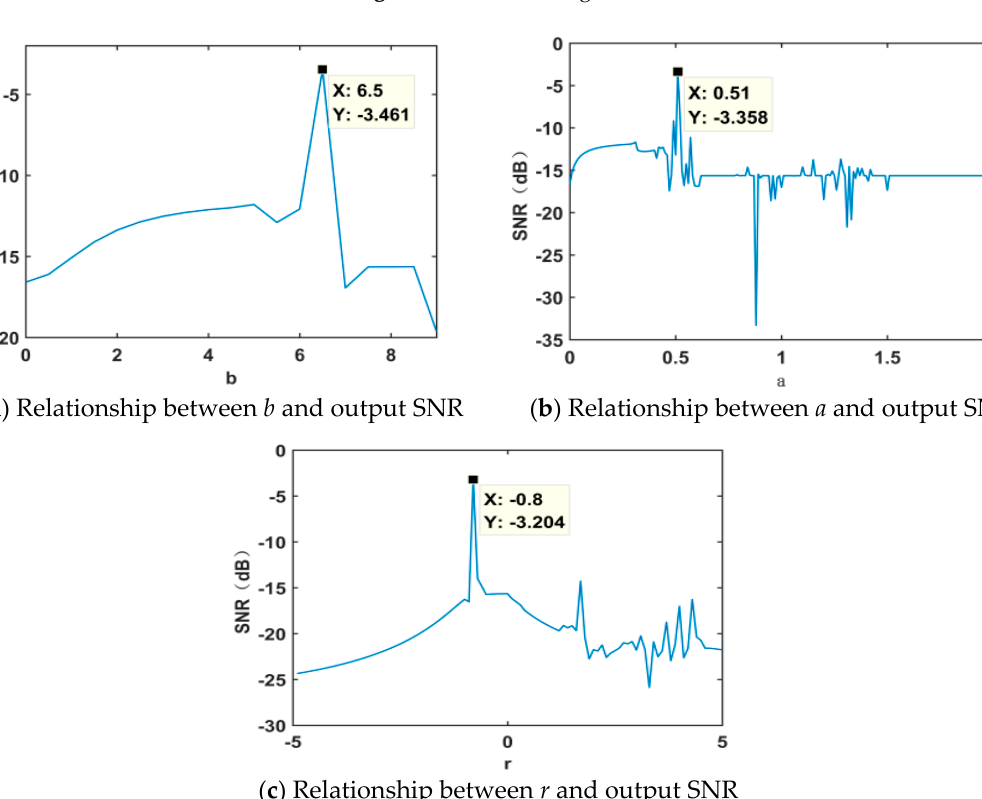
Figure 4. Simulation signal.